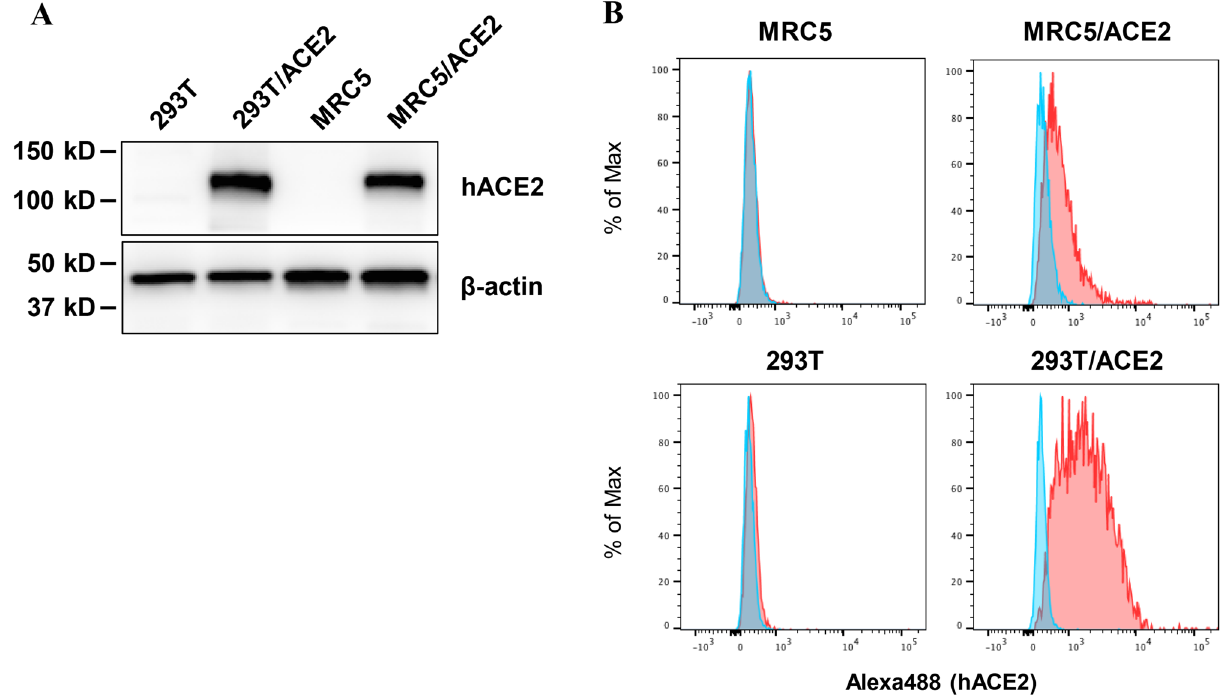
Figure 1. Expression of human ACE2. ( A ) Expression of immunoreactive human ACE2 (hACE2) in each of the lentiviral-transfected cell lines was examined using an anti-ACE2 antibody. Expression of β-actin was used as a loading control. Full-length blots are presented in Supplementary Figure S4. ( B ) Flow cytometric analysis of surface expression of hACE2 in MRC5, MRC5/ACE2, 293T and 293T/ACE2 cells using anti-ACE2 (red) or isotype control (blue)